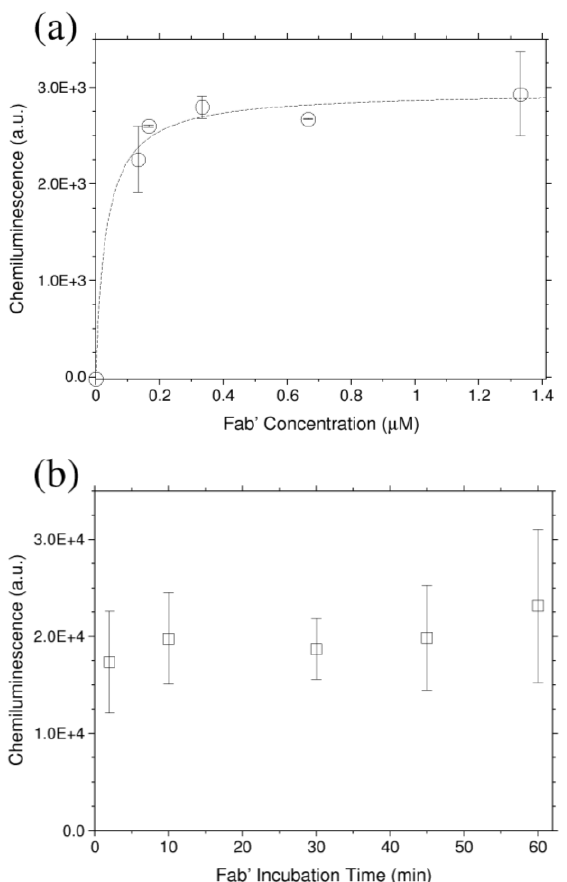
Figure 2. ( a ) Chemiluminescence detection of AFM1-HRP incubated on Fab’ prepared surface. The protocol described in Section 2.2 was applied changing the Fab’ concentration (incubation time 2 min). ( b ) For a 0.33 μM Fab’ concentration, the AFM1-HRP recognition was evaluated as a function of the delay before PEG addition (incubation time). The reported values represent the mean value on